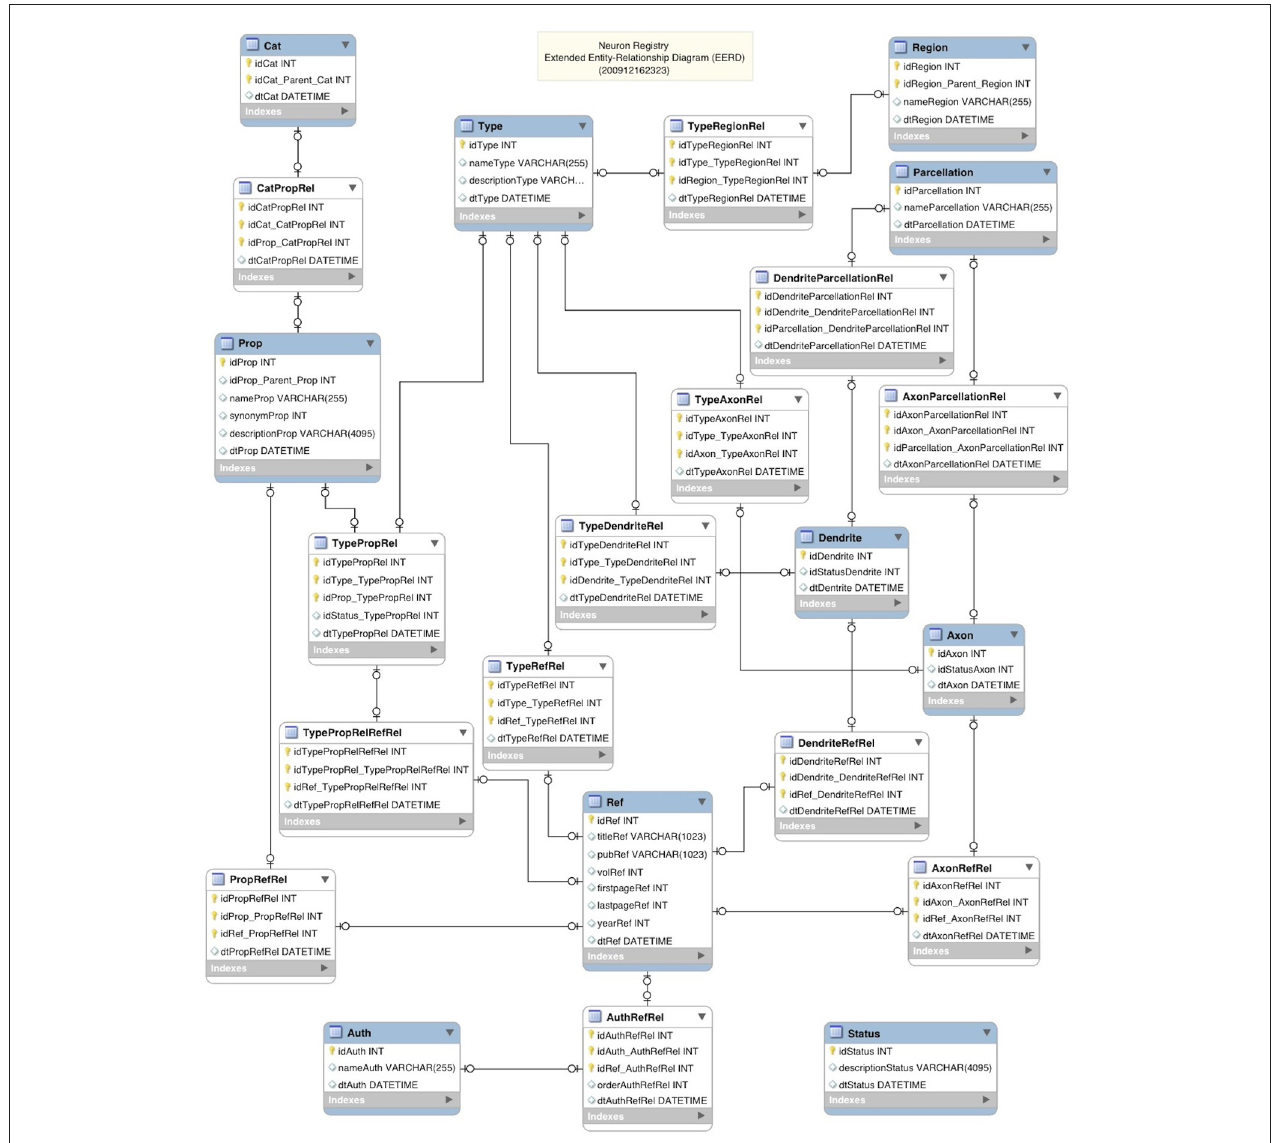
FIGURE 5 | Neuron Registry Extended Entity-Relationship